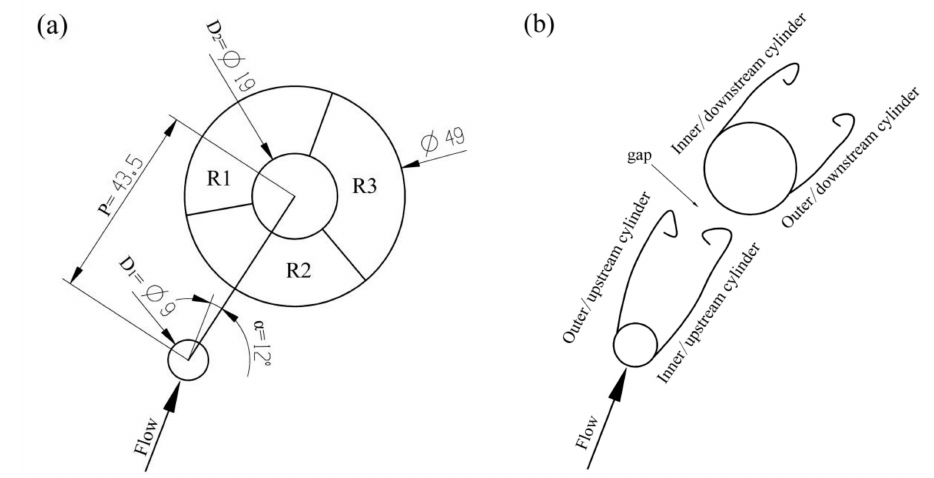
Figure 10. Schematic diagram showing ( a ) the arrangement of the two cylinders in the right window; ( b ) shear layer designations.